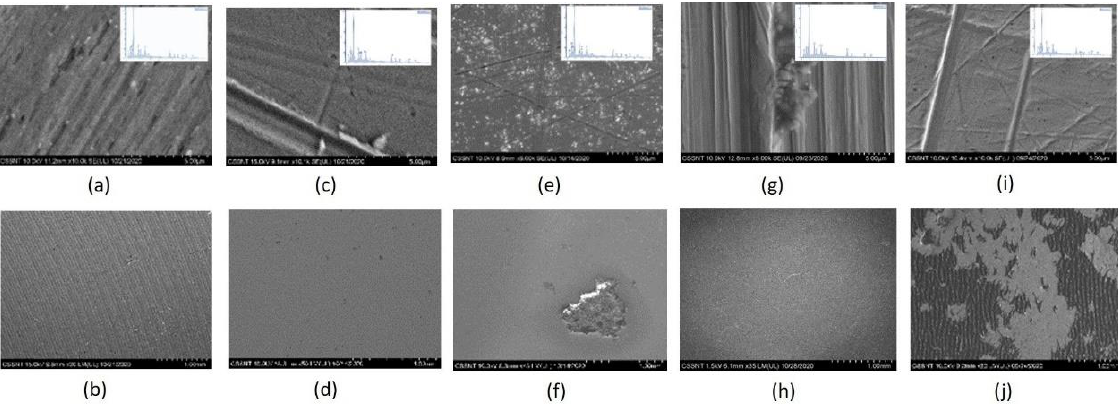
Figure 9. SEM micrographs and EDS analysis (inset) for NiCr alloy at two different magnification (35 x and 10 kx) ( a ) and ( b ) 290 K, ( c ) and ( d ) 300 K, ( e ) and ( f ) 310 K, ( g ) and ( h ) 320 K, ( i ) and ( j ) 330 K.